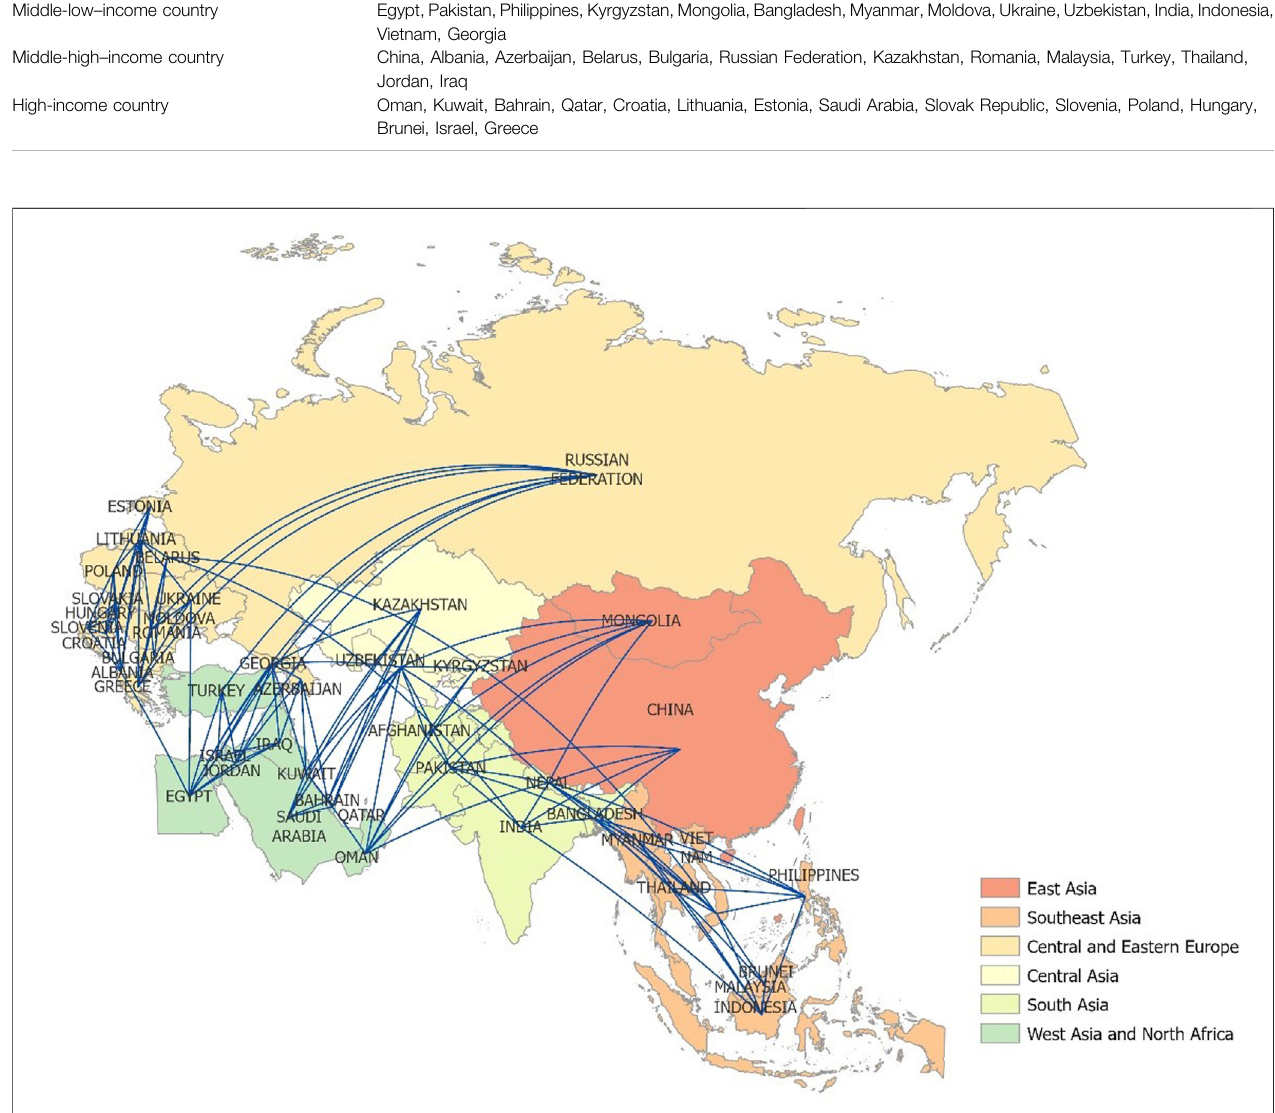
FIGURE 1 | Spatial correlation network of environmental risks in the BRI.